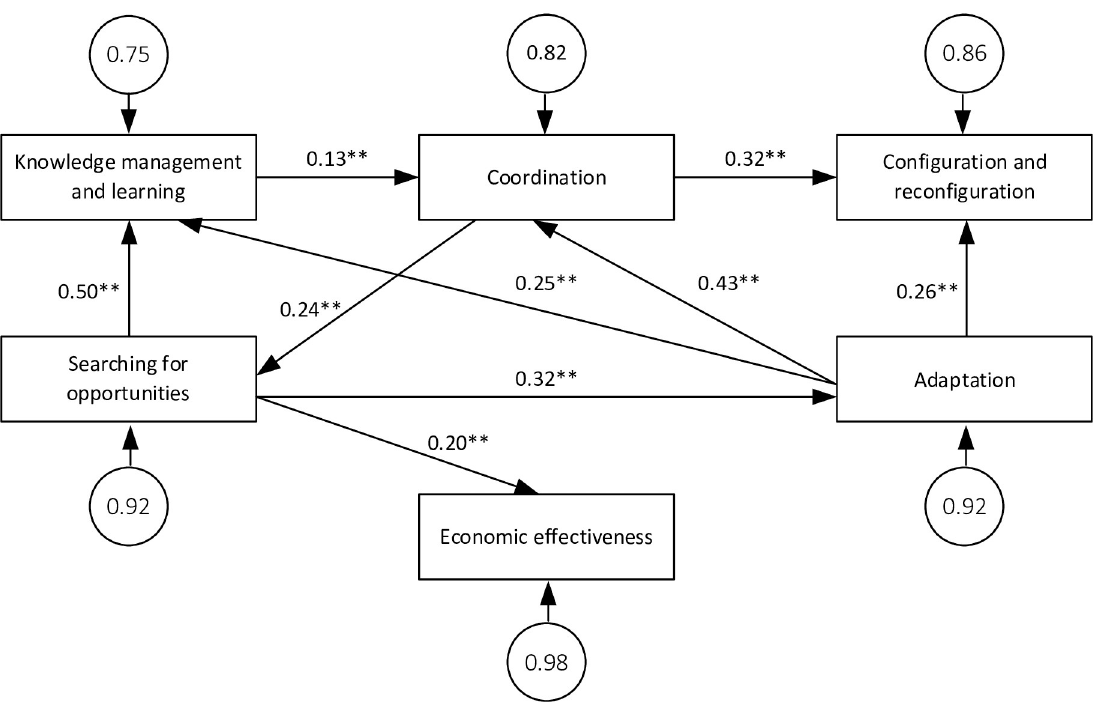
Fig 5. Results of SEM analysis. Source: Own study.